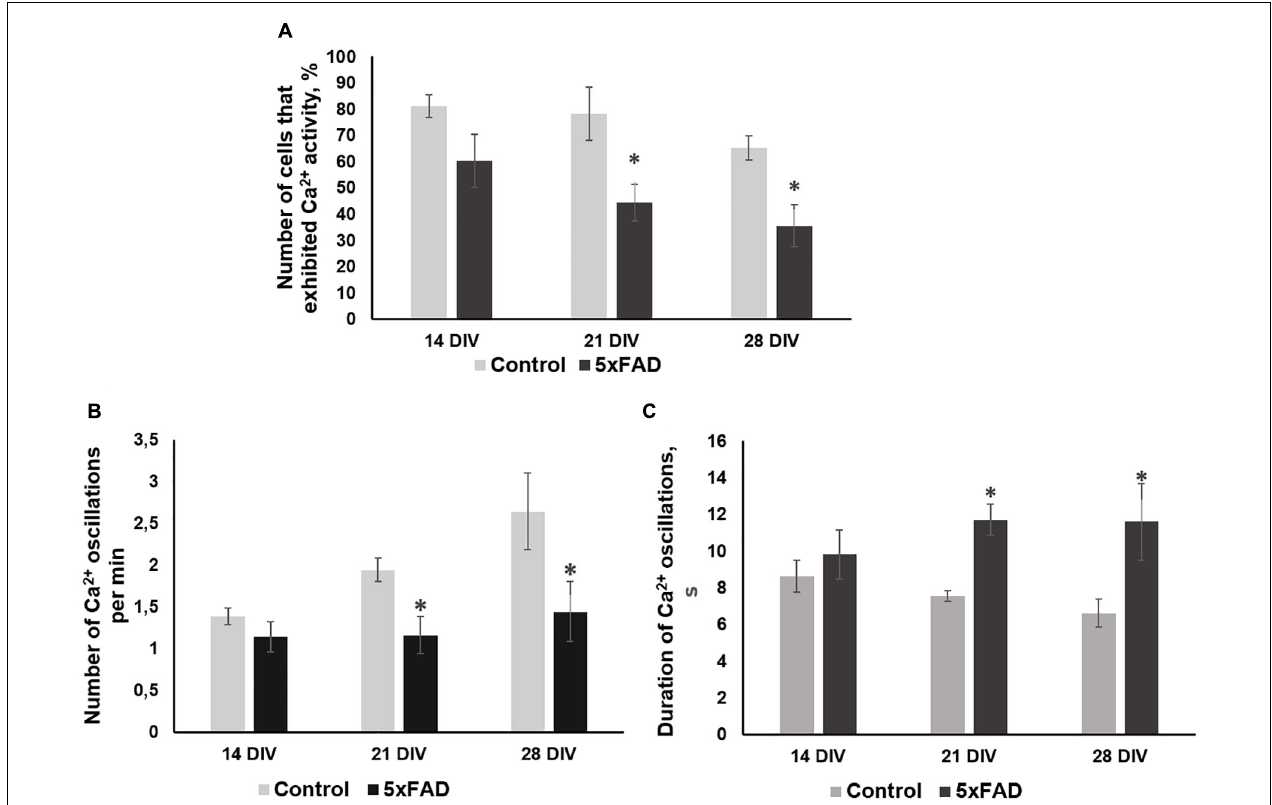
FIGURE 4 | Main parameters of spontaneous calcium activity in primary hippocampal cultures obtained from wild-type and 5xFAD murine embryos (E18) during development in vitro . (A) Proportion of cells exhibiting Ca 2 + activity; (B) number of Ca 2 + oscillations per min; (C) duration of Ca 2 + oscillations. ∗ vs. “Control,” p < 0.05, ANOVA. The functional Ca 2 + activity of 5xFAD primary neuronal cultures was significantly altered in comparison with that of wild-type murine primary cultures. The percentage of cells that exhibited Ca 2 + activity and the frequency of Ca 2 + oscillations in the cultures obtained from 5xFAD murine embryos were significantly lower than that in control cultures. Additionally, the duration of Ca 2 + oscillations in 5xFAD primary cultures was 1.55 (DIV 21) and 1.75 (DIV 28) times higher than those in control cultures.